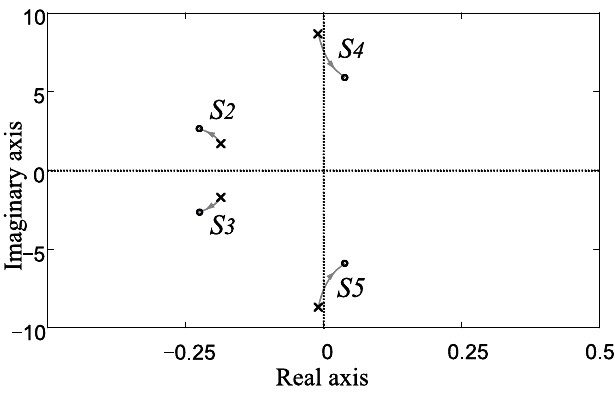
Figure 8. The root locus of D (s) following m 1 changes when m 2 = 5 × 10 − 5 Hz/W.